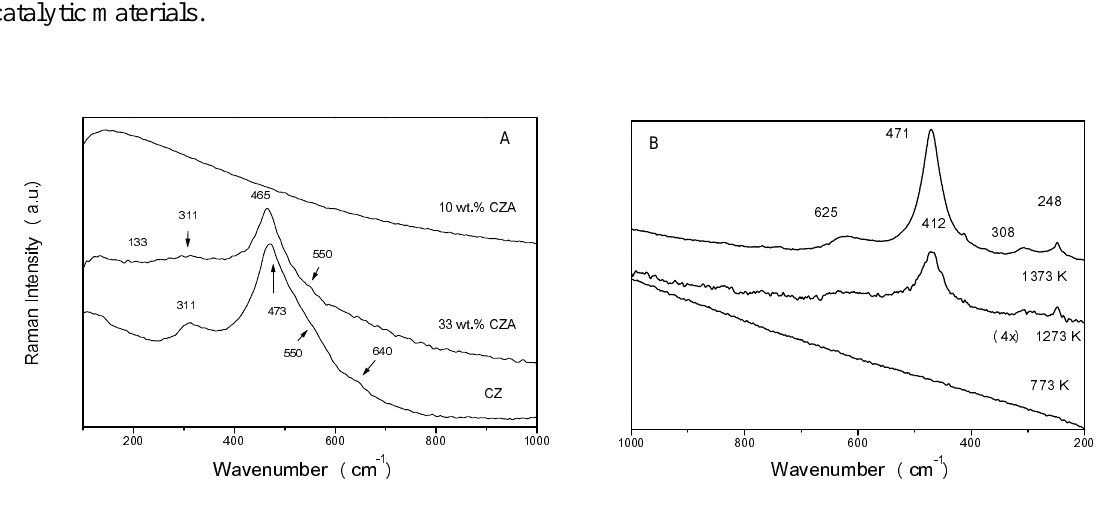
Fig. 1 Raman Spectra of CZA systems: A) with different CZ loading; B) 10 wt.% CZ on alumina aged at different